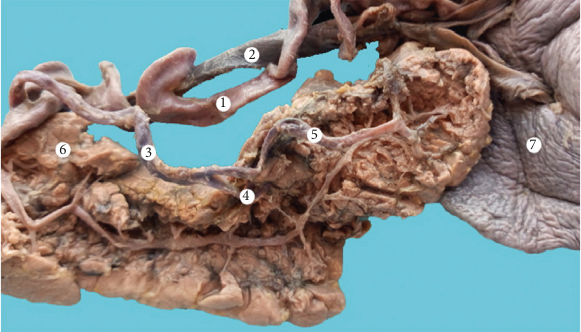
Figure 5: Type III vascular supply of the pancreas (dissection) 1—splenic artery; 2—splenic vein; 3—great pancreatic artery; 4—superior branch of the great pancreatic artery; 5—inferior branch of the great pancreatic artery; 6—pancreas; 7—spleen.